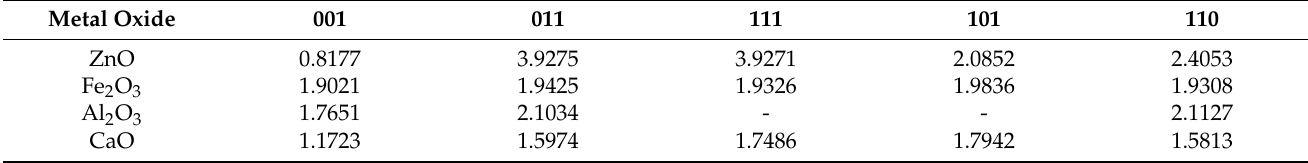
Table 3. Common surface energies of metal oxides (J/m 2